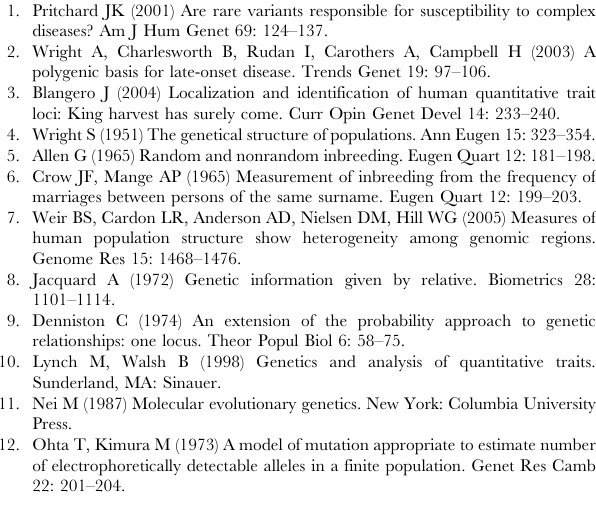
Figure S1 The moment estimates of Fst as a function of number of allelic types. The horizontal lines show the actual values of Fst. This figure shows bias, especially for small number of alleles. Figure S2 Posterior expectation of coancestry (see Methods), which is the expected proportion of the number of shared alleles of a marker between a pair of individuals by IBD. Results obtained by real data of a marker D6S962 of 375 unrelated healthy Japanese individuals and by those of simulated data are shown. For the simulations we assumed that the Japanese population founded 884 generations ago and the effective size is 2,500. We simulated 10 populations with these parameters (10 6 375 6 374/ 2 =701250 pairs in total). The left ordinate is for the real data and the right ordinate is for the simulated data. Although simulated and observed distributions were similar, they differed to some degree. It probably means that the demography of the Japanese is not as simple as was assumed in the isolated random mating